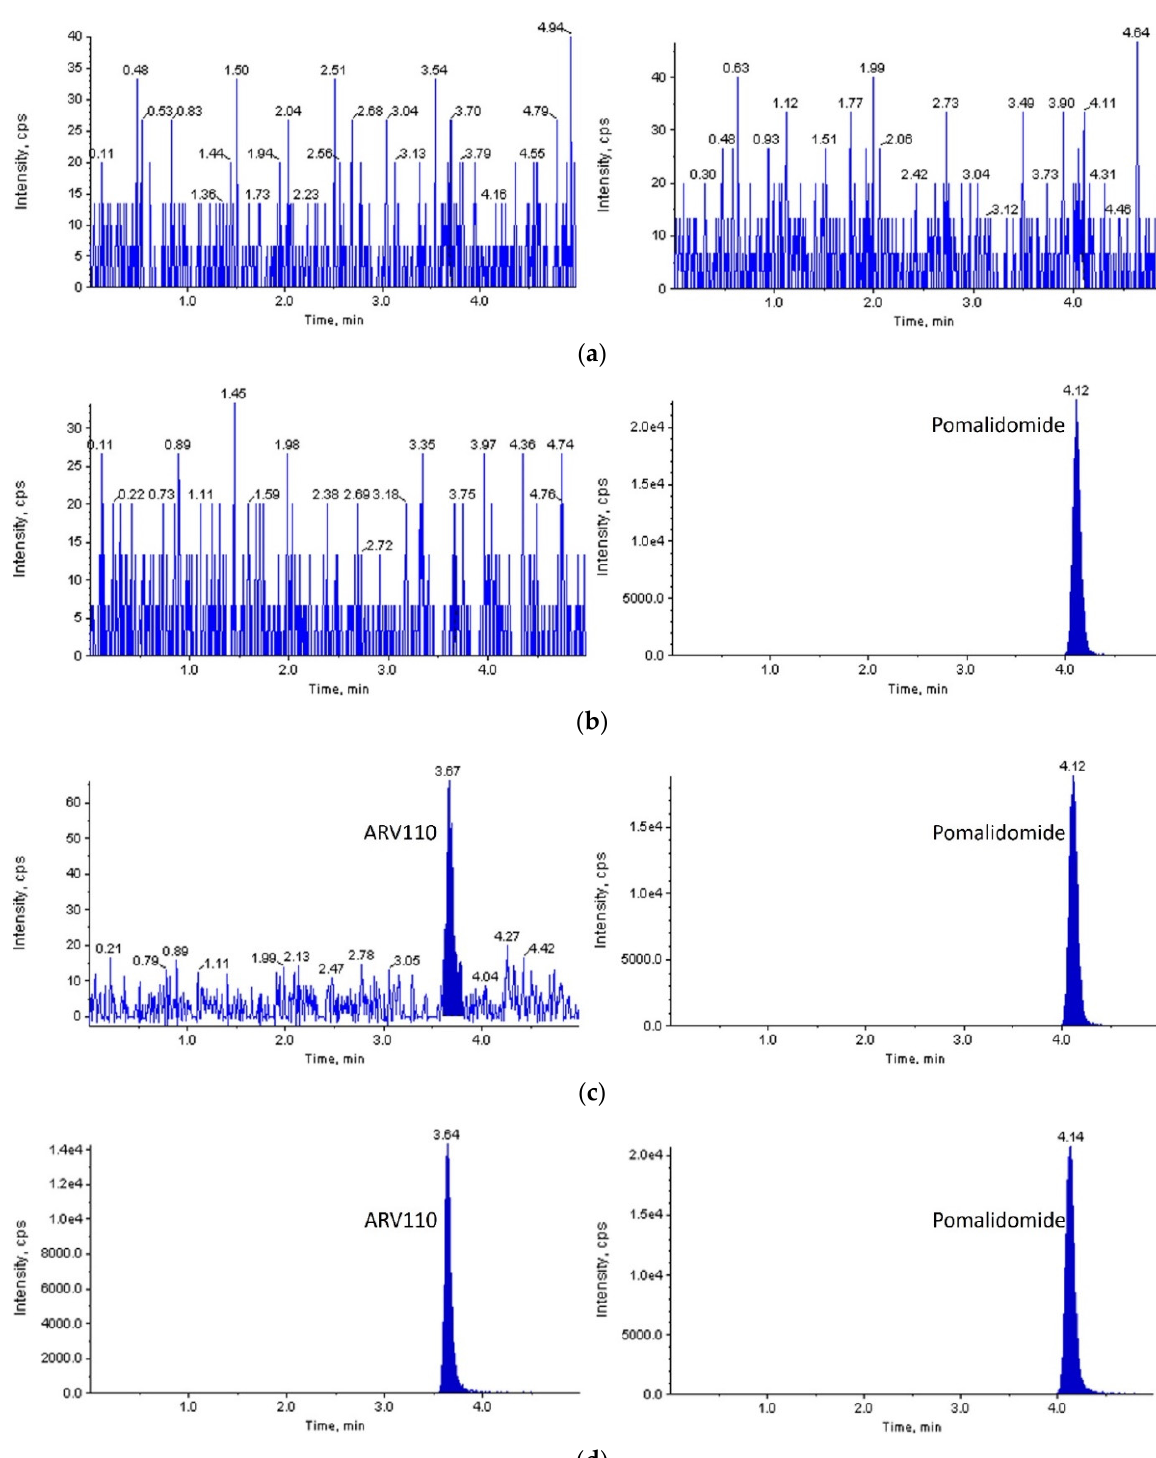
Figure 3. MRM LC-MS/MS chromatograms of ARV-110 (left) and pomalidomide (right) after deproteinization of blank mouse plasma ( a ); zero calibrator ( b ); LLOQ ( c ); and mouse plasma sample 60 min after PO administration of ARV-110 at a dose of 2 mg/kg ( d ). The calibration curves for ARV-110 in rat and mouse plasma showed good linearity over the range of 2–3000 ng/mL with a weighting factor of 1/x 2 . The linear equations